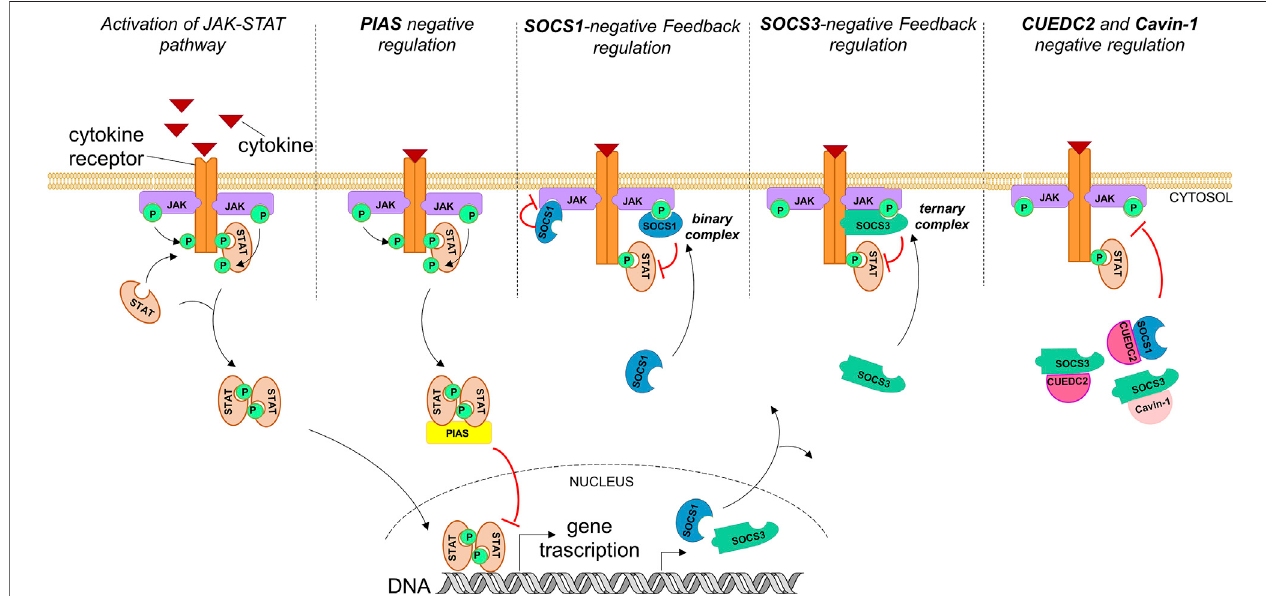
FIGURE 1 | Endogenous activation of the JAK-STAT pathway and its regulation through natural inhibitors. PIASs act mainly by suppressing STAT-regulated gene expression and inhibiting STAT binding toDNA. Hyperactivation ofthe JAK-STAT pathway also activates its own negativefeedback regulators: SOCSproteins. SOCS1 and SOCS3 inhibit signaling by different mechanisms: SOCS1 forms a binary complex with JAKs (phosphorylated or unphosphorylated) and inhibits their catalytic activity; SOCS3 inhibits JAK activity through the formation of a ternary complex, binding simultaneously to the cytokine receptor and JAKs. Cavin-1 and CUEDC2 inhibit the JAK-STAT pathway by interacting with SOCS1,3 via an SH2 domain PEST